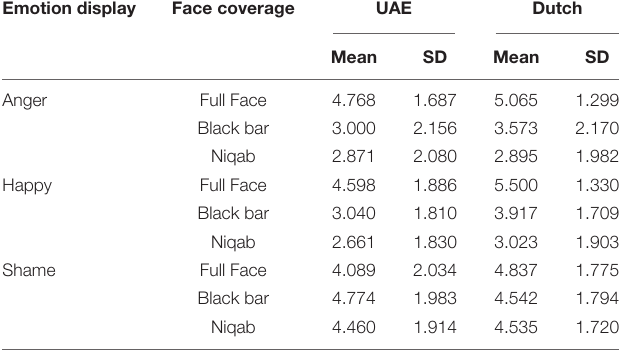
TABLE 1 | Descriptives.